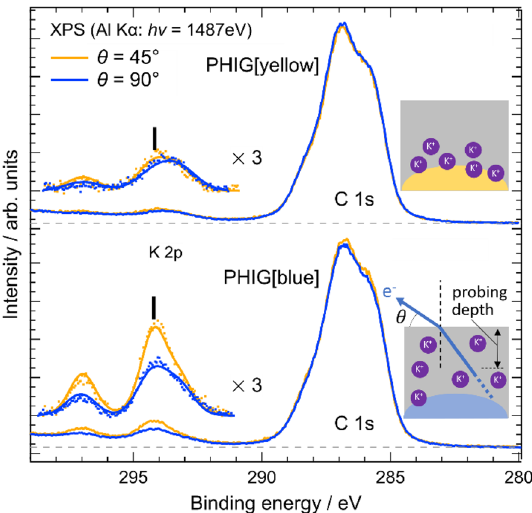
Figure 4. Angle-resolved XPS measurements of the C 1 s and K 2p core levels of PHIG[yellow] and PHIG[blue]. Colored dots are the measured spectra after subtracting Shirley-type backgrounds. Each spectrum was normalized by the intensity of the N 1 s peak of the Bmmim cation at around 402 eV. θ represents the take- off angle of the photoelectron from the sample surface, as illustrated in the